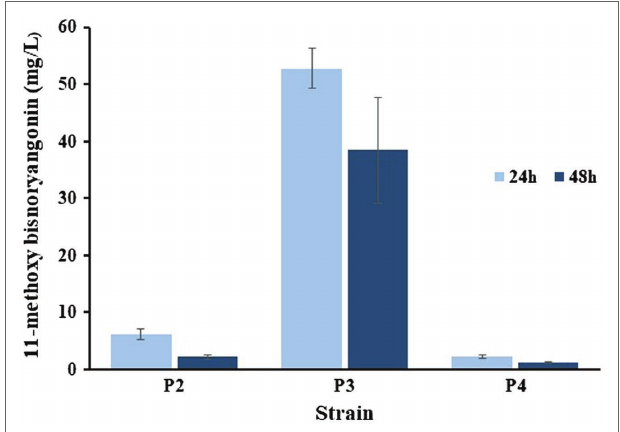
FIGURE 7 | Comparisons of the 11-methoxy-bisnoryangonin productivity. The data were obtained after 24–48 h culture of P2, P3, and P4 strains in a minimal glucose medium. Error bars show one standard deviation from triplicate